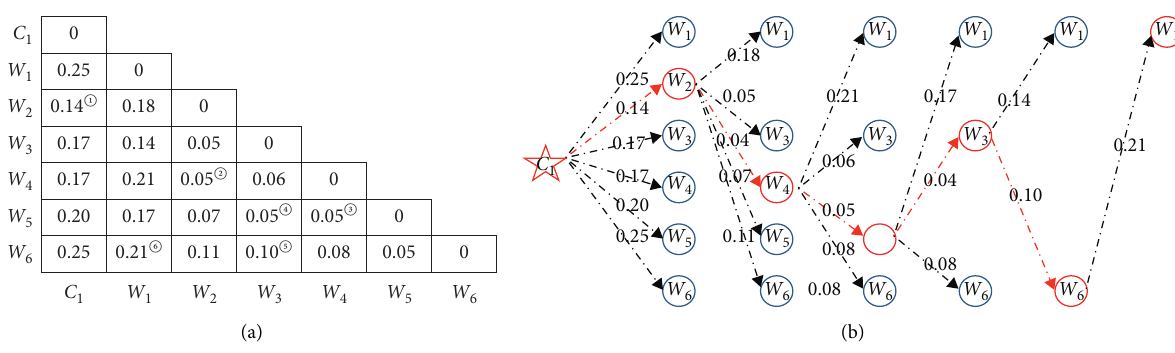
Figure 3: Schematic diagram of the corresponding shortest weeding path calculated manually. (a) The results of using the manual measurement method to carry out distance data statistics. (b) The manual calculation process of the shortest path planning algorithm